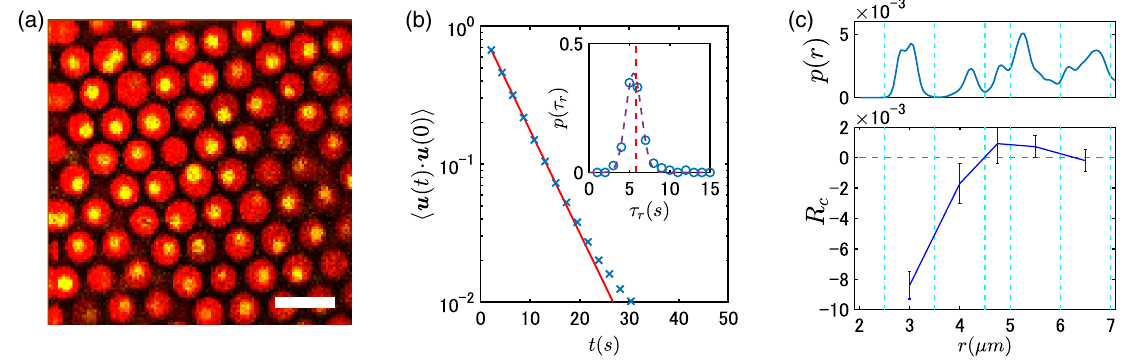
FIG. 3. Rotational motion in a charged colloidal crystal of OCULI particles. (a) Two-channel confocal microscopy image of OCULI particles. The scale bar is 5 μ m. (b) Average autocorrelation function of unit orientation vectors over time, and an exponential fit (red solid line). Inset: distribution of relaxation times for single particles in a field of view (symbols) and a Gaussian fit (purple dashed line). The red vertical dashed line shows the average relaxation time found from the exponential fit to the average autocorrelation function. (c, upper) Probability distribution p ð r Þ of interparticle distances in the charged crystal. (c, lower) Rotation-rotation coupling constant R c ≈ 2 s. Error bars [Eq. (2)] for different coordination shells around a central particle (separated by vertical light blue dashed lines) for τ r correspond to the standard error in the mean value of R for particles in each r c